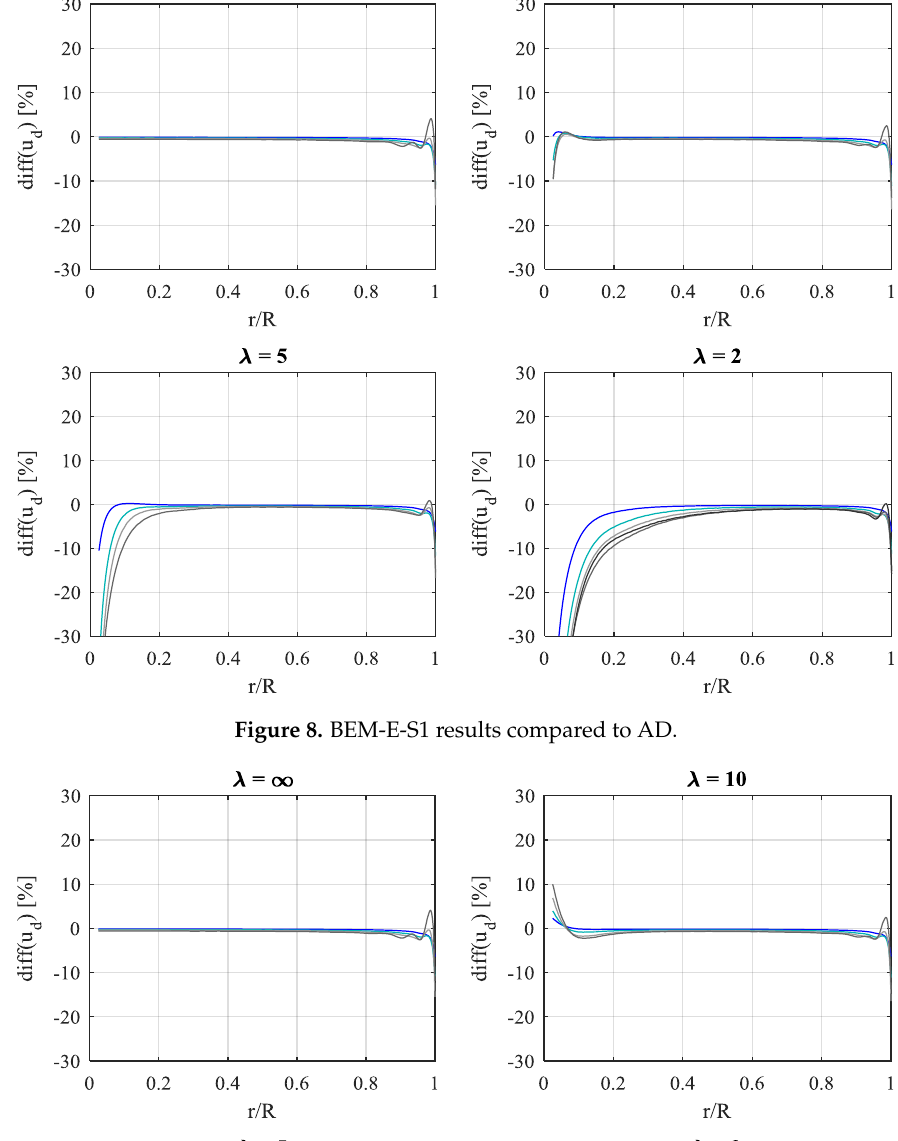
Figure 7. BEM-E results compared to AD.